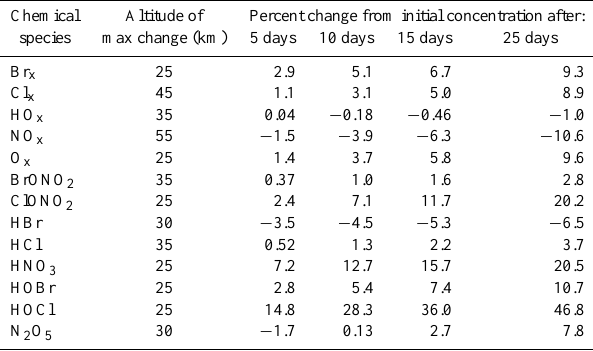
Table 2. Maximum percent change from initial condition through- out the stratosphere, after 5, 10, 15, and 25 days of simulation for the relevant chemical species, with corresponding altitude.